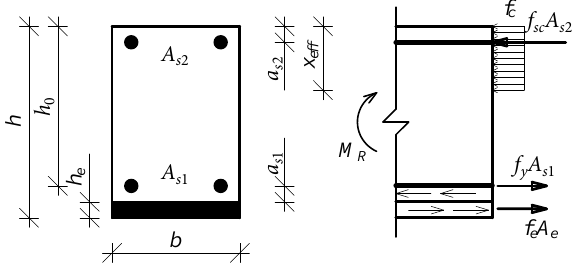
Fig. 4. The design scheme for deflection